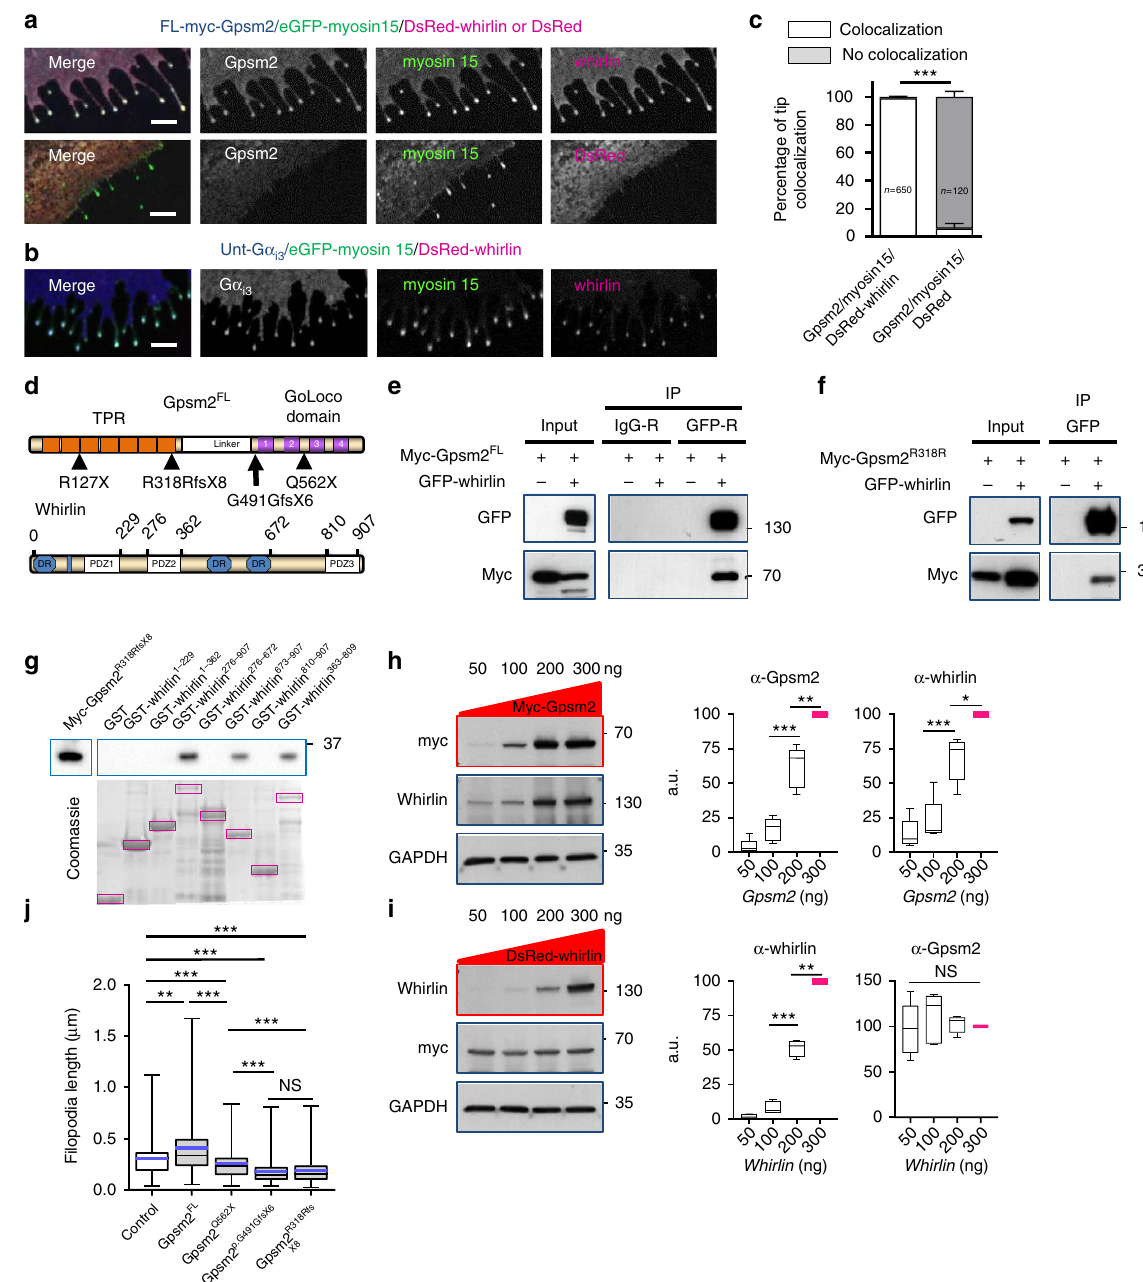
Figure 6 | New protein complex between Gpsm2 and whirlin. ( a – c ) COS-7 cells transiently transfected with GFP–Myo15, DsRed-whirlin, myc-Gpsm2 FL , untagged G a i3 or DsRed as indicated. ( a ) Co-expression of myosin 15 and whirlin leads to the formation of actin-rich filopodial structures with Gpsm2 accumulating at the tip with the two proteins. Absence of whirlin (DsRed only) markedly reduces the colocalization at the tips. ( b ) G a i3 also accumulates at the tip of filopodia with myosin 15 and whirlin. Transfections were repeated more than three times. Scale bars, 4 m m. ( c ) Percentage of filopodia tips ( ± s.e.m.) displaying colocalization of Gpsm2, myosin 15 and whirlin in the two contexts. n ¼ number of filopodia tips from three independent experiments. *** P o 0.001 with Mann–Whitney test. ( d ) Schematic representation of Gpsm2 FL and whirlin proteins. Four variants identified in CMCS patients, including Gpsm2 R318RfsX8 are indicated. ( e ) Whirlin co-immunoprecipitates with myc-Gpsm2 FL but not with non-immune IgG. ( f ) The interaction is maintained, though reduced, with the Gpsm2 R318RfsX8 (Gpsm2 R318R ) variant. Representative images of n 4 3 independent experiments. ( g ) A GST-pull-down assay indicates that the unstructured region of whirlin between aa 672 and aa 810 binds to Gpsm2 R318RfsX8 . Representative image of n ¼ 3 independent experiments. ( h , i ) Increasing amounts of myc - Gpsm2 FL - encoding cDNA over constant amounts of whirlin leads to a net increase in whirlin expression levels, whereas increasing doses of whirlin had no significant effect on Gpsm2 levels. Five independent experiments presented as whisker box plots (min/max) combined with dot plot (blue bars representing the mean values) *** P o 0.001, ** P o 0.01, * P o 0.05 (for h , i ) with one simple t -test or one-way ANOVA (post-hoc Bonferonni’s test). NS, not significant. ( j ) Gpsm2 FL significantly increased the length of filopodia generated by eGFP–myosin 15 and DsRed-whirlin (control) in COS-7 cells. Constructs bearing CMCS mutations led to shorter filopodia, compared with control or to Gpsm2 FL . Data are presented as whisker box plots (min/max) from three independent experiments ( n ¼ 220, 207, 345, 228 and 188 filopodia, in the order indicated on the histogram’s x axis) (blue bars represent the mean values). *** P o 0.001, ** P o 0.01 with Kruskal–Wallis test (post-hoc Dunn’s Multiple Comparison Test). NS, not